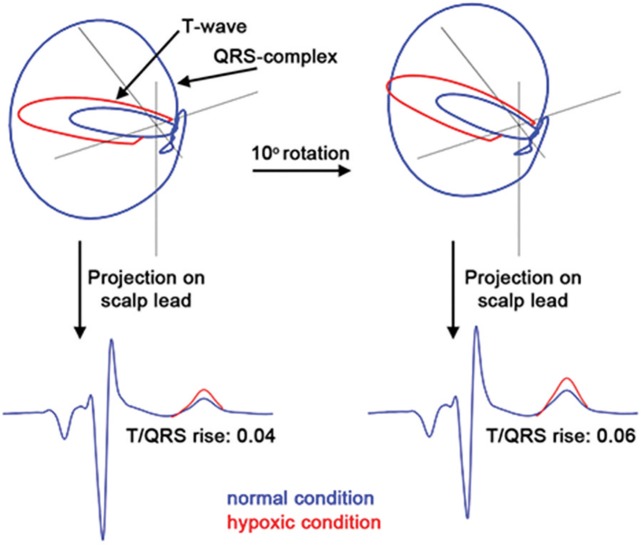
The fetal vectorcardiogram for different orientations of the electrical heart axis.In the top panels, the electrical currents within the heart during a cardiac cycle are depicted in terms of their vectorcardiogram; ventricular contraction (QRS-complex = large loop), relaxation phase (T-waves = small loop). From left to right, the entire vectorcardiogram has been rotated over 10 degrees to simulate a different orientation of the electrical heart axis. Note that these vectorcardiograms are 3-dimensional images and the 10 degree rotation was performed in 3-dimensional space. In the bottom panels, the fetal scalp ECG has been calculated by projecting the vectorcardiograms onto the scalp lead. Before rotation, the baseline T/QRS is 0.05 and the T/QRS rise resulting from hypoxia is 0.04, yielding no ST event. After rotation, the baseline T/QRS is 0.09 and the T/QRS rise resulting from the same level of hypoxia is 0.06, yielding a ST event.